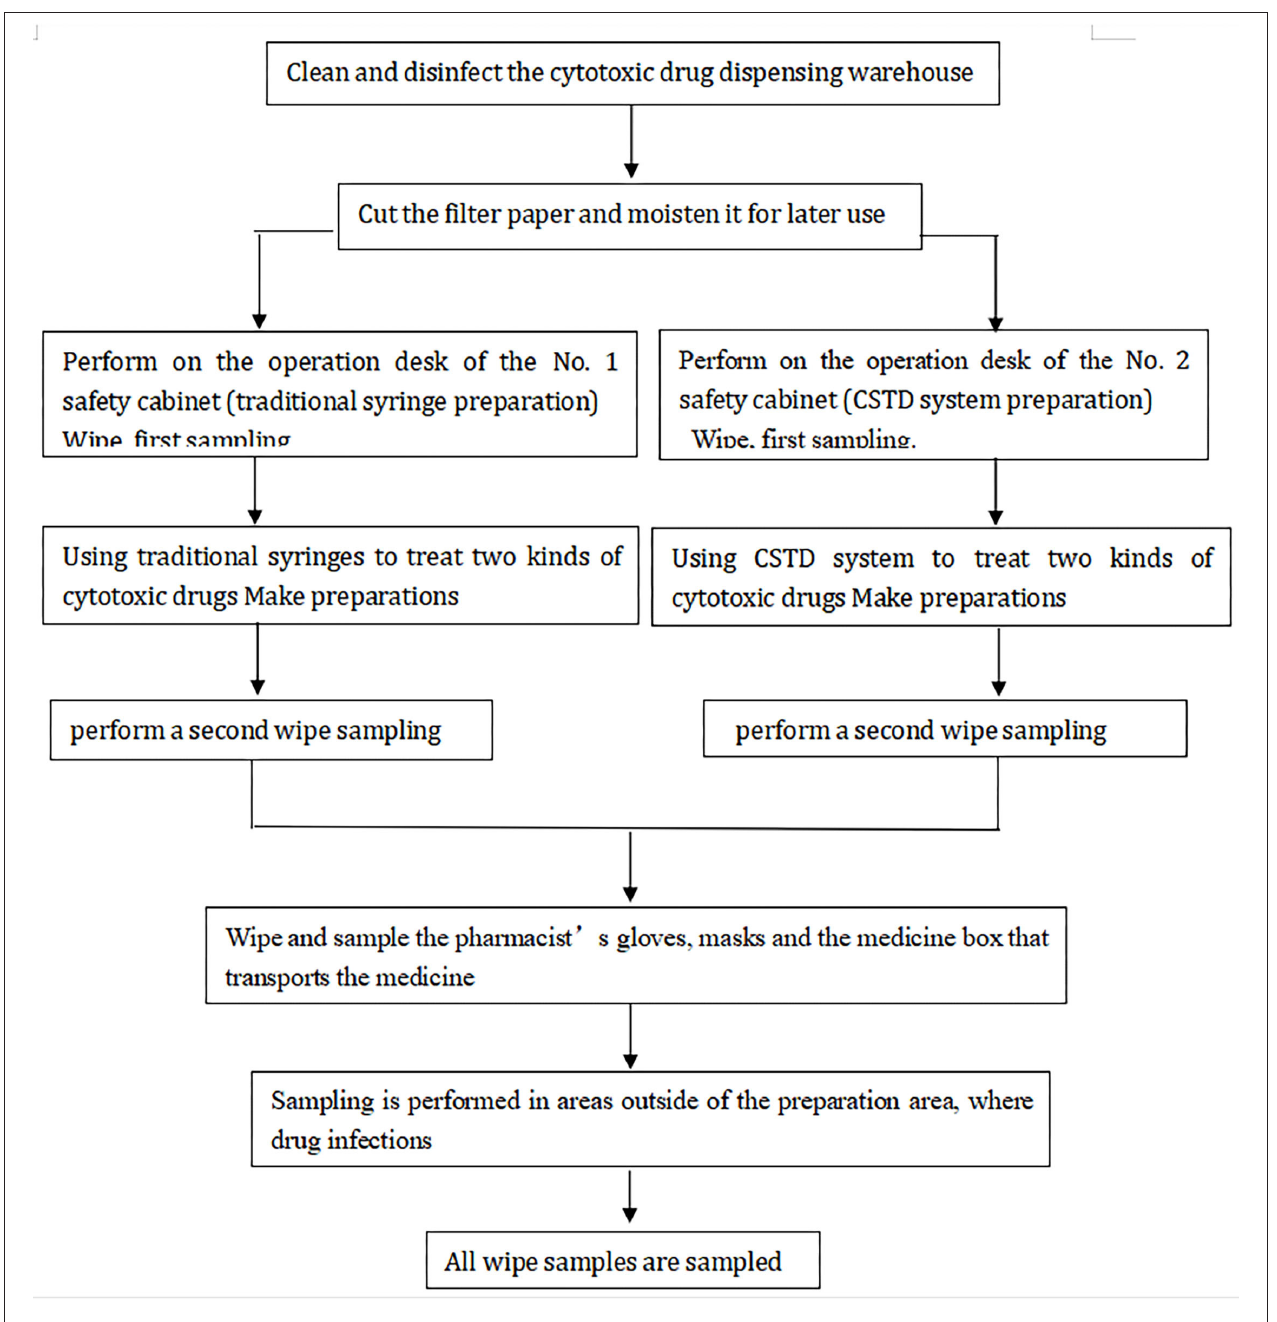
FIGURE 2 | The study process for contamination prevention of two systems.